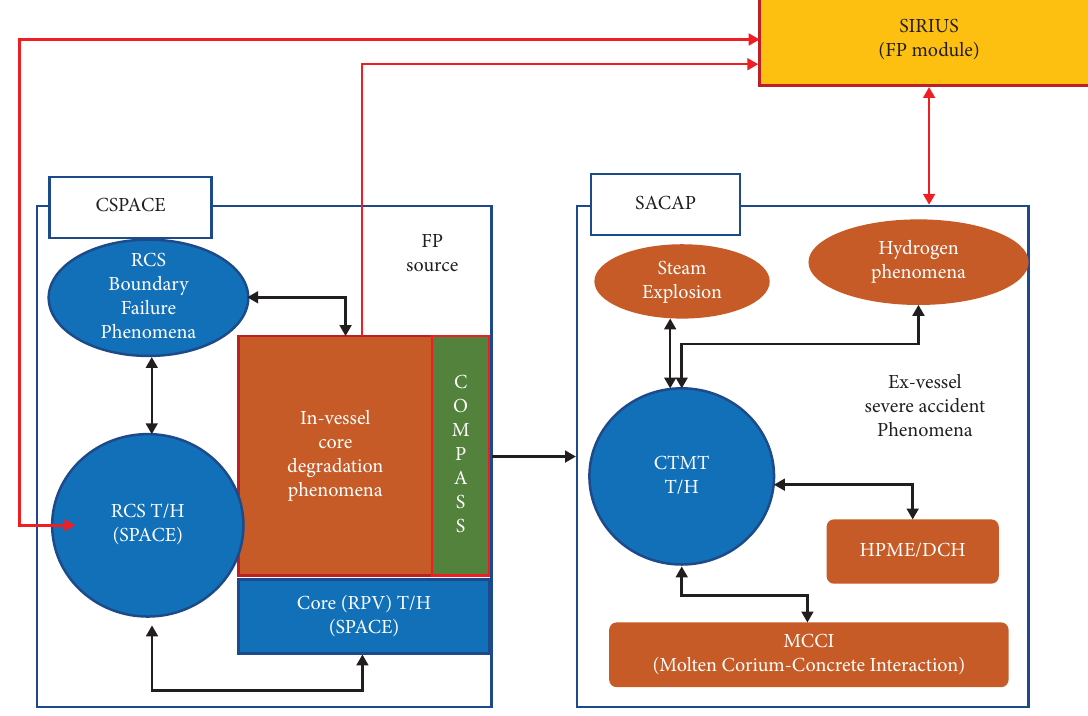
Figure 1: Structure of CINEMA computer